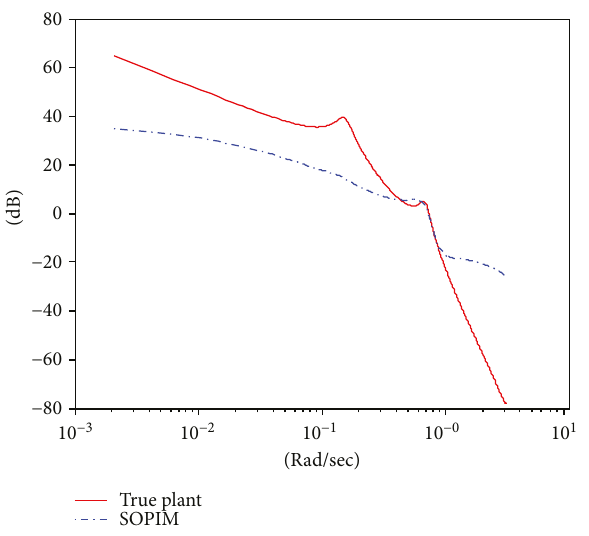
Figure 3: SOPIM Bode amplitude tracking curve.